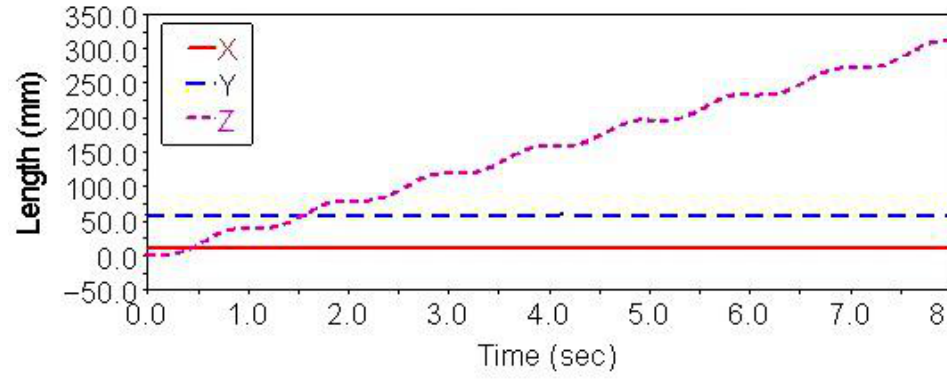
Figure 14. Centroid displacement curve of climbing step.